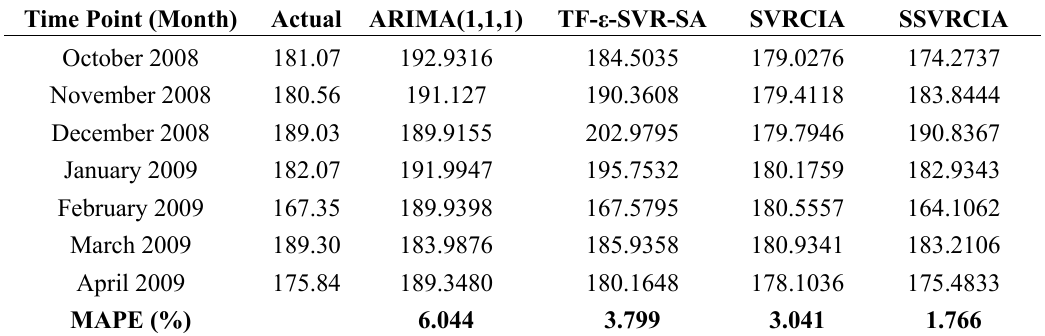
Table 6. Forecasting results of the ARIMA, TF- ε -SVR-SA, SVRCIA, and SSVRCIA models (units: hundred million kW/h).